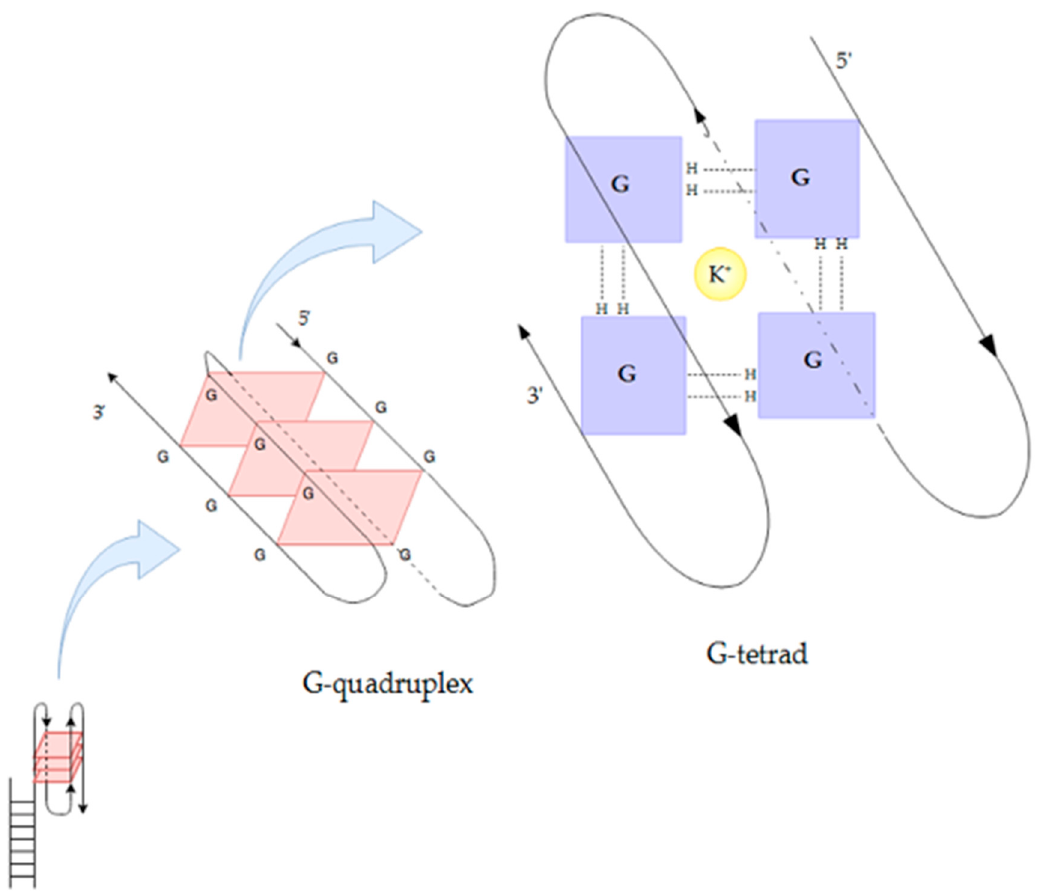
Figure 1. Schematic representation of an antiparallel G-quadruplex formed from a single DNA strand. This type of structure can form at telomere ends, protecting and stabilising the single strand overhang. The G-quadruplex is composed of several stacked G-tetrads, each of which is in turn formed by four guanines (G) joined by Hoogsteen hydrogen bonding and stabilised by a monovalent cation (K + in this figure).